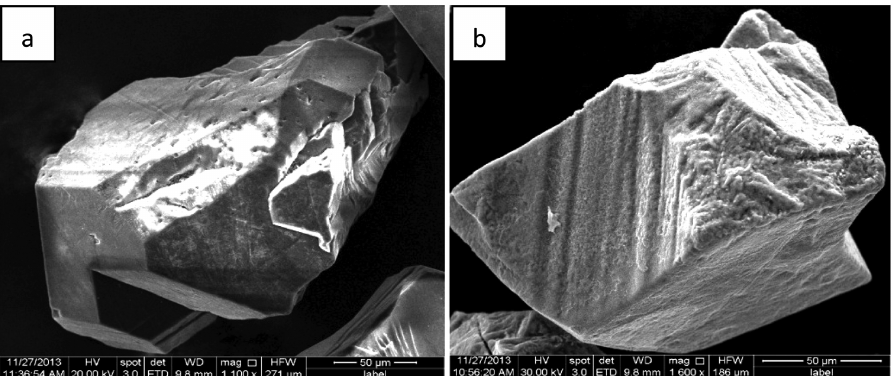
Figure 4: SEM micrographs of diamonds: (a) without coating and (b) with Cr coating.